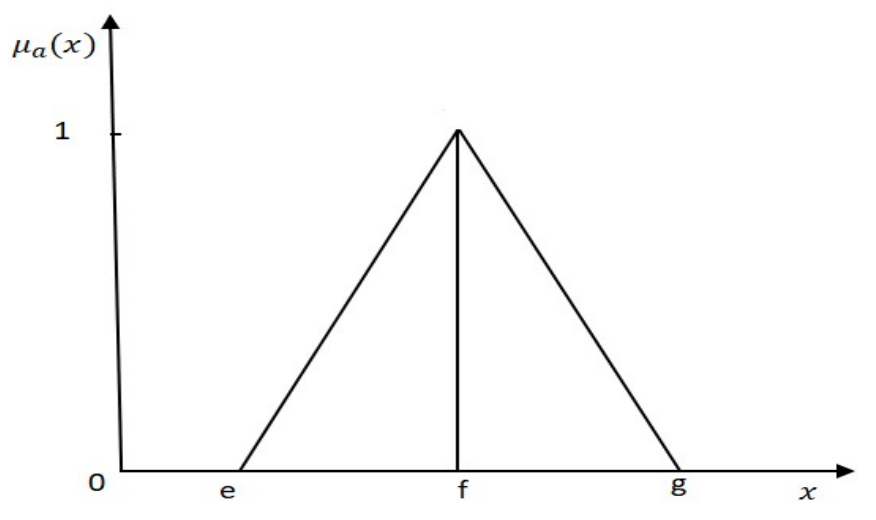
Figure 1. Triangular Fuzzy Number.